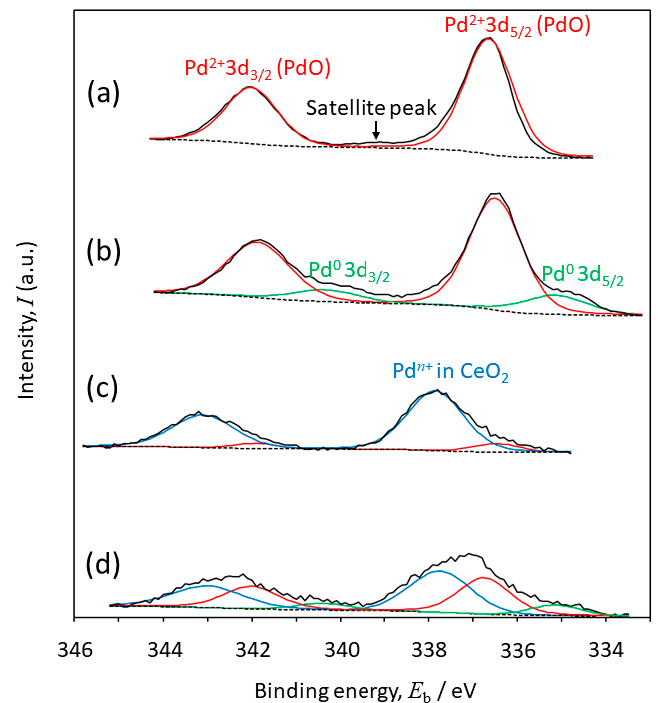
Figure 8. Pd3dspectraof( a )as-synthesizedPdO,( b )PdOafterheatingat900 ◦ Cfor2h, ( c )as-synthesized PdCe4, and ( d ) PdCe4 after heating at 900 ◦ C for 2